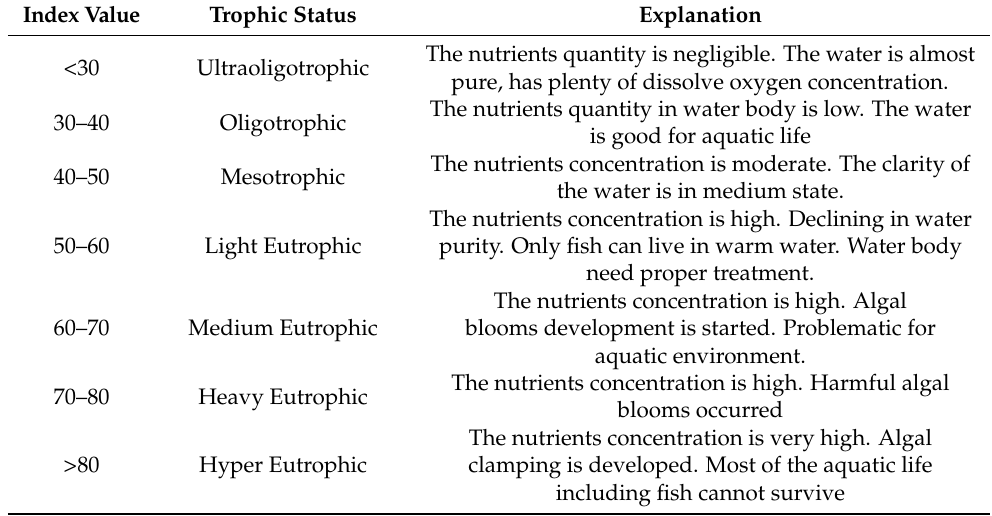
Table 4. Carlson Trophic Index classification